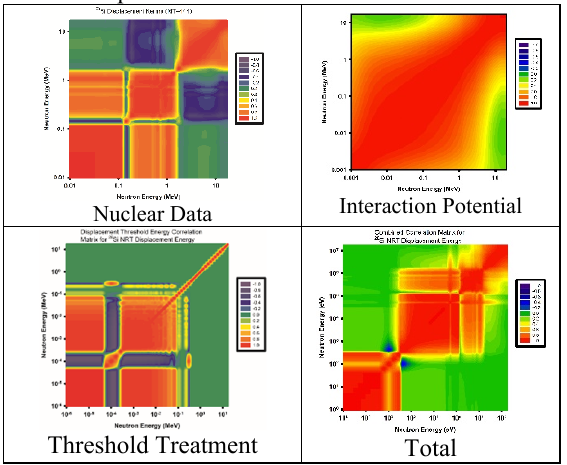
Fig. 11. Correlation matrices various uncertainty contributors in the 28 Si damage energy